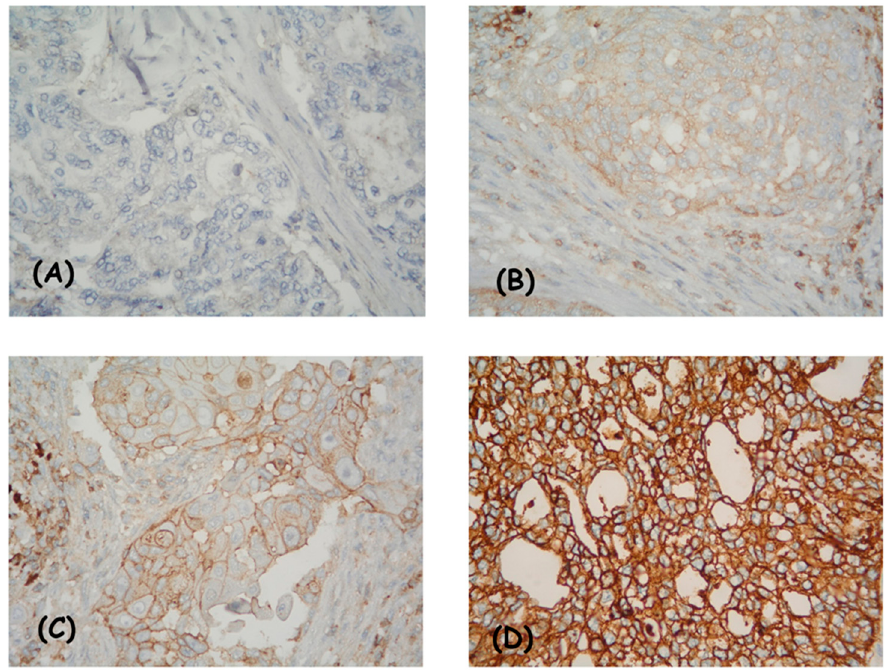
Figure 1. IHC expression model of CD47 in patients with cervical adenocarcinoma: membrane positivity—missing ( A ), weak ( B ), average ( C ), and strong intensity ( D ). Magnification ×400.